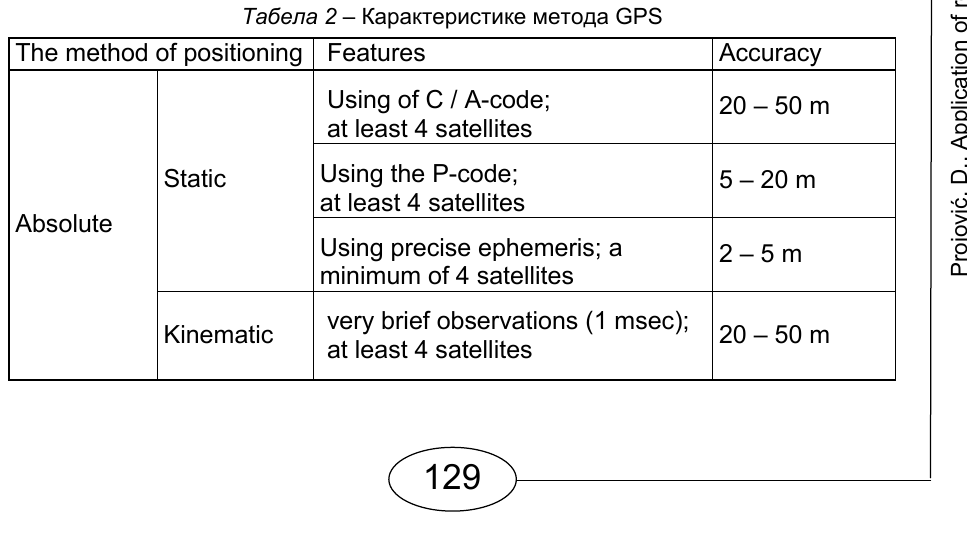
Table 2 – Features of the GPS methods Таблица 2 – Характеристики методов GPS Табела 2 – Карактеристике метода